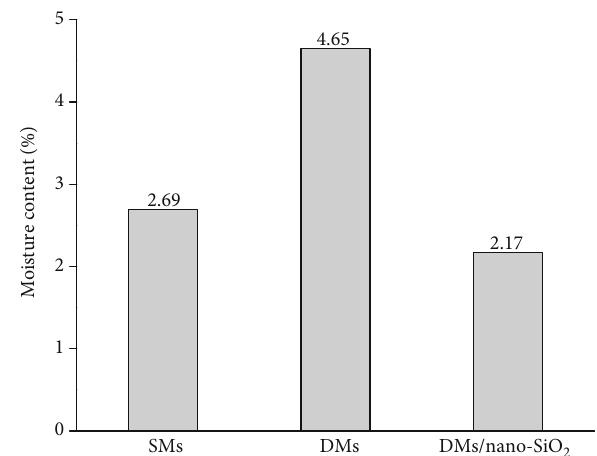
Figure 2: The moisture contents of SMs, DMs, and DMs/nano- . SiO 2